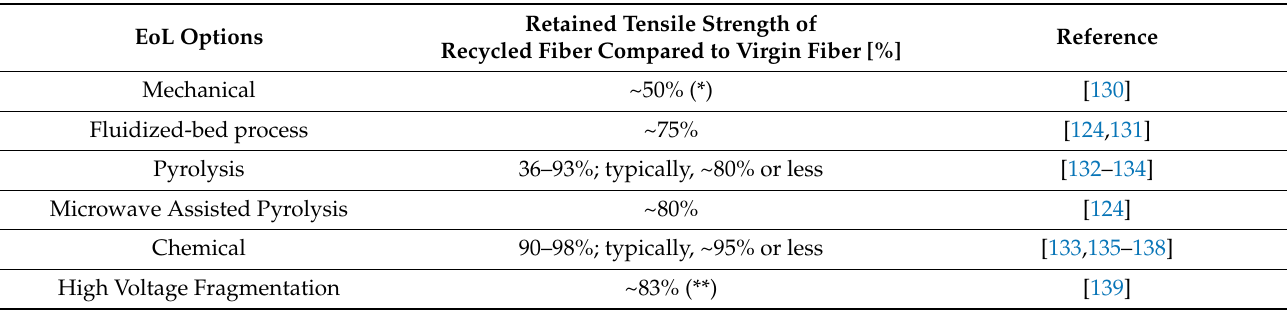
Table 3. Recycled CF retained tensile strength compared to virgin CF, based mainly on